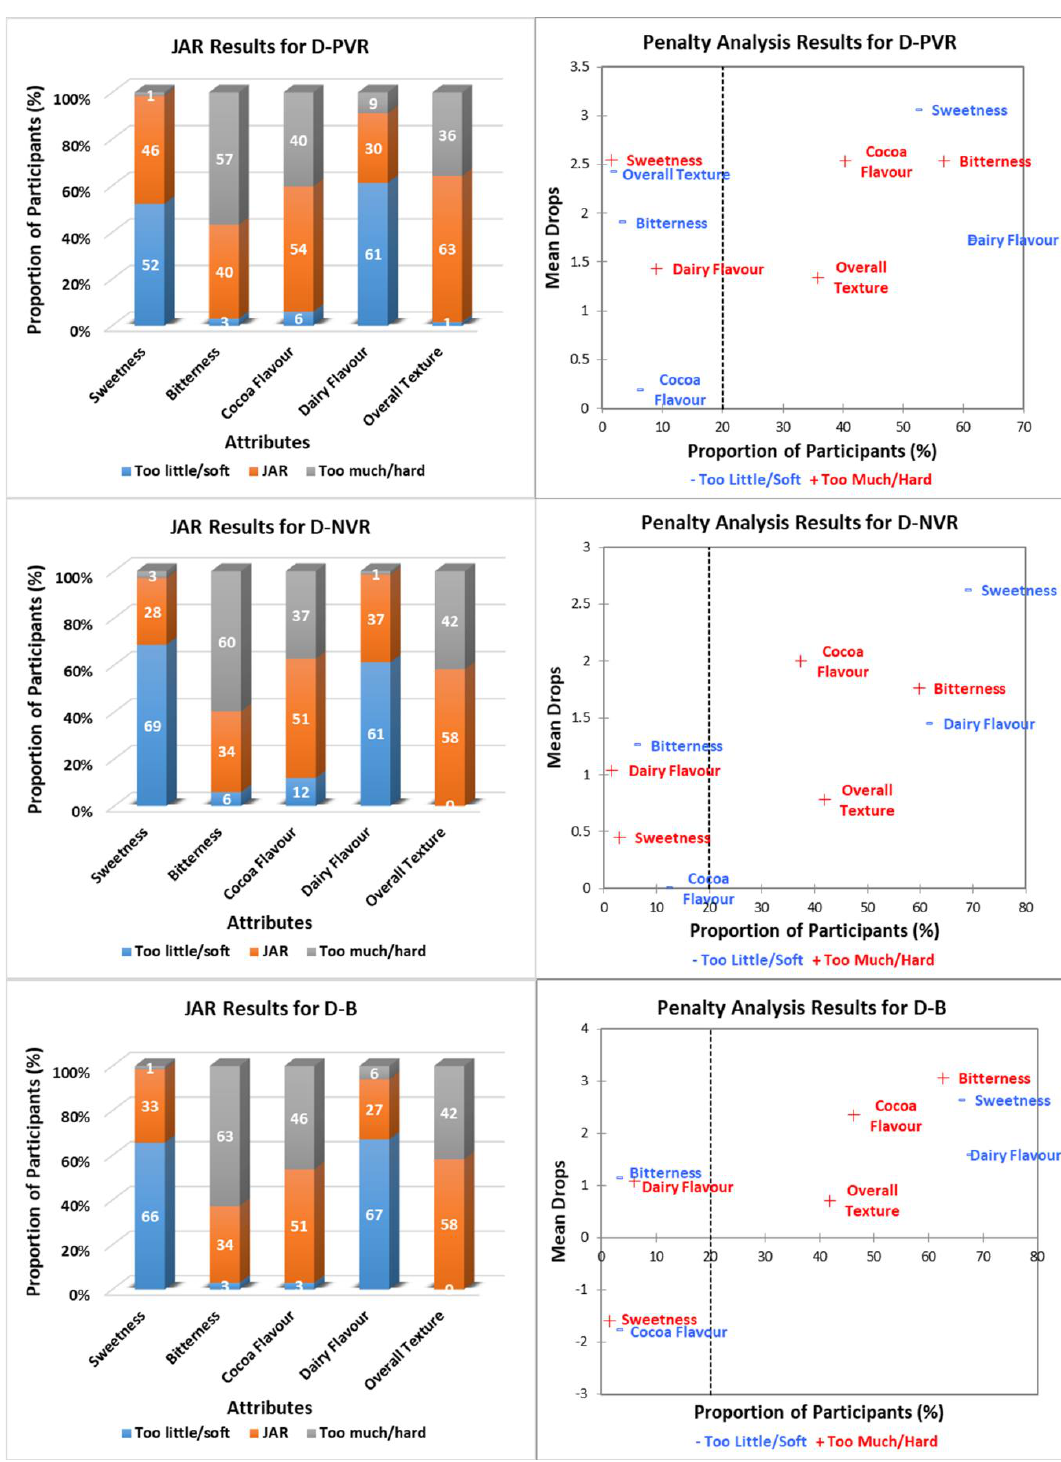
Figure 5. Just-About-Right (JAR) frequencies and penalty analysis results 1 regarding dark chocolate attributes under different environments 2 . 1 Penalty analysis was associated with the overall liking scores (9-point hedonic scale). 2 D-PVR: dark chocolate positive VR; D-NVR: dark chocolate negative VR; D-B: dark chocolate sensory booth.